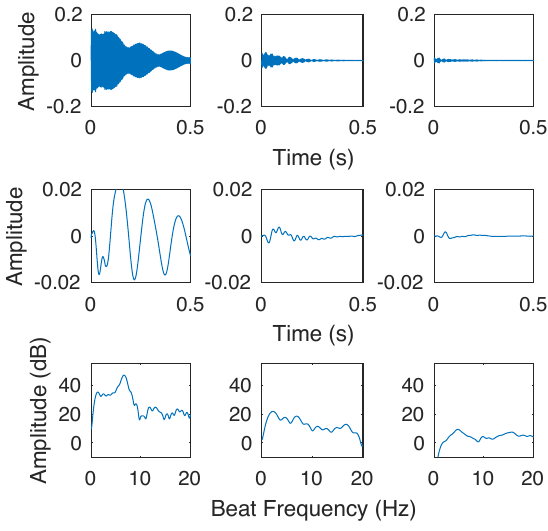
Figure 8. Beating analysis of octave Bb5–Bb6 tuned using an alternative rule m2. Cf. Figure